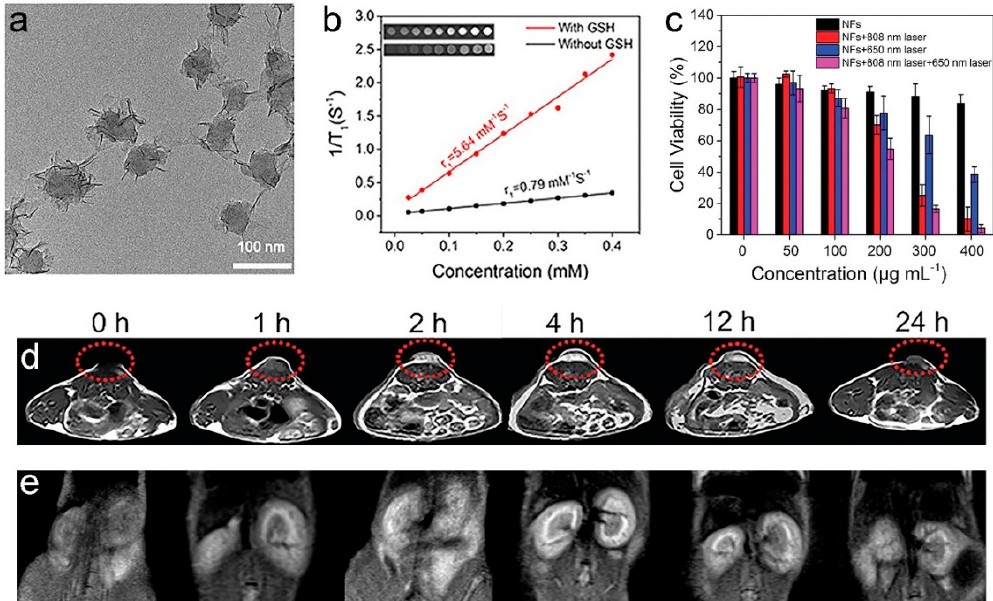
Figure 12. ( a ) TEM micrographs of PDA@ut-MnO 2 /MB NFs. ( b ) The r 1 values of PDA@ut-MnO 2 /MB NFswithandwithout5mmolL − 1 GSH.( c )AnassessmentofPDT / PTTe ffi cacyusingPDA@ut-MnO 2 /